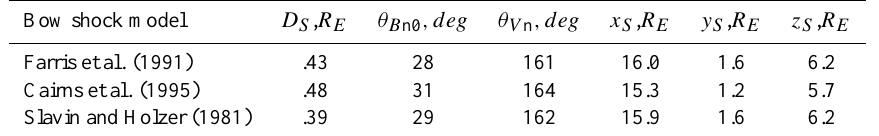
Table 2. Intersection of the IMF line with the bow shock. Bow shock